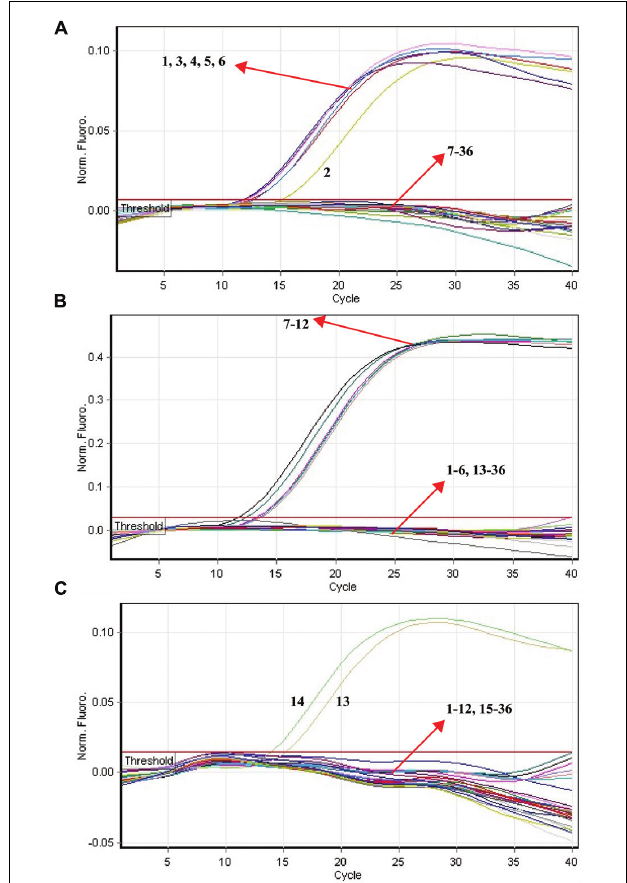
FIGURE 8 | The analytical specificity of multiplex ET-PCR detection of different strains. The multiplex ET-PCR reactions were carried out using different genomic templates and were analyzed by means of real-time detection. (A–C) were simultaneously generated from HEX, Cy5, and FAM channels, respectively. Signals 1-6, strains of S. pneumoniae (ATCC6314 ), S. pneumoniae (ATCC49619 ), S. pneumoniae (ATCCBAA660 ), S. pneumoniae (ATCC700669 ), S. pneumoniae (ATCCBAA659 ), S. pneumoniae (ATCCBAA658 ); signals 7–12, S. aureus (ICDC-NPSau001), S. aureus (ICDC-NPSau002), S. aureus (ICDC-NPSau003), S. aureus (ICDC-NPSau004), S. aureus (ICDC-NPSau005), S. aureus